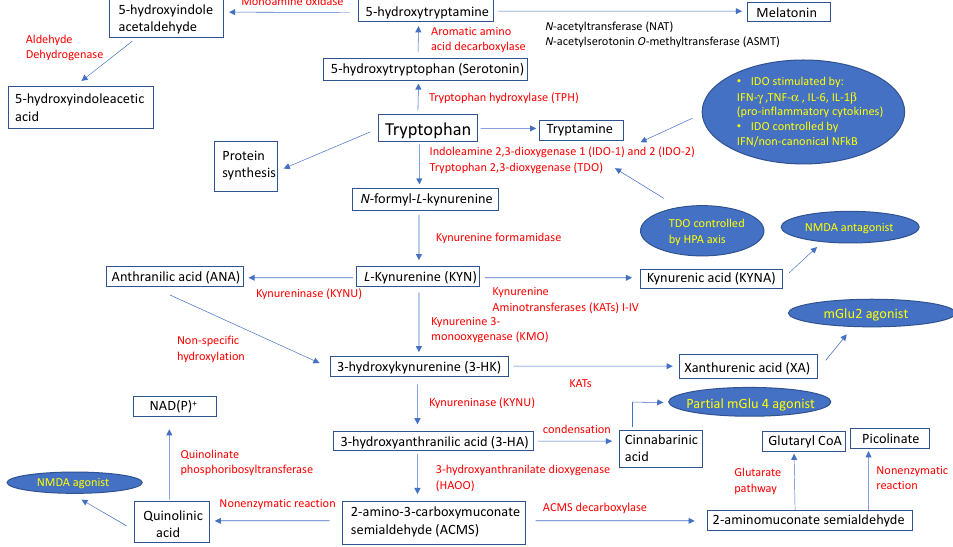
Figure 1. Schematic description of tryptophan metabolic pathways with assigned physiological roles and regulatory points of select metabolites. Abbreviations: HPA, hypothalamic pituitary adrenal; IFN- γ , interferon- γ ; IL-1 β , interleukin IL-1 β ; IL-6, interleukin IL-6; mGlu2, metabotropic glutamate receptor 2; mGlu4, metabotropic glutamate receptor 4; NAD(P) + , nicotinamide adenine dinucleotide phosphate; NF κ B, nuclear factor- κ B; NMDA, N -methyl- D -aspartate; TNF- α ; tumor necrosis factor α .